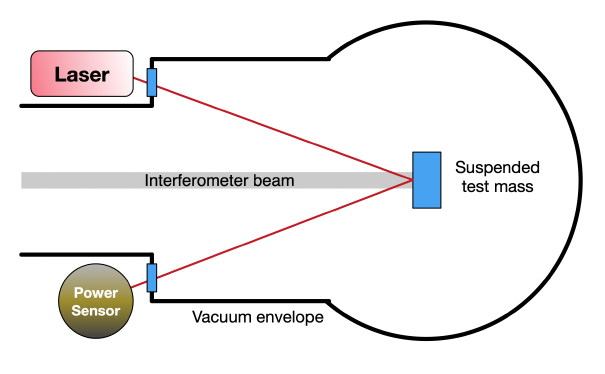
Figure 1. Simplified schematic diagram of a photon calibrator. Variations of this nominal configura- tion are being employed in all second-generation GW